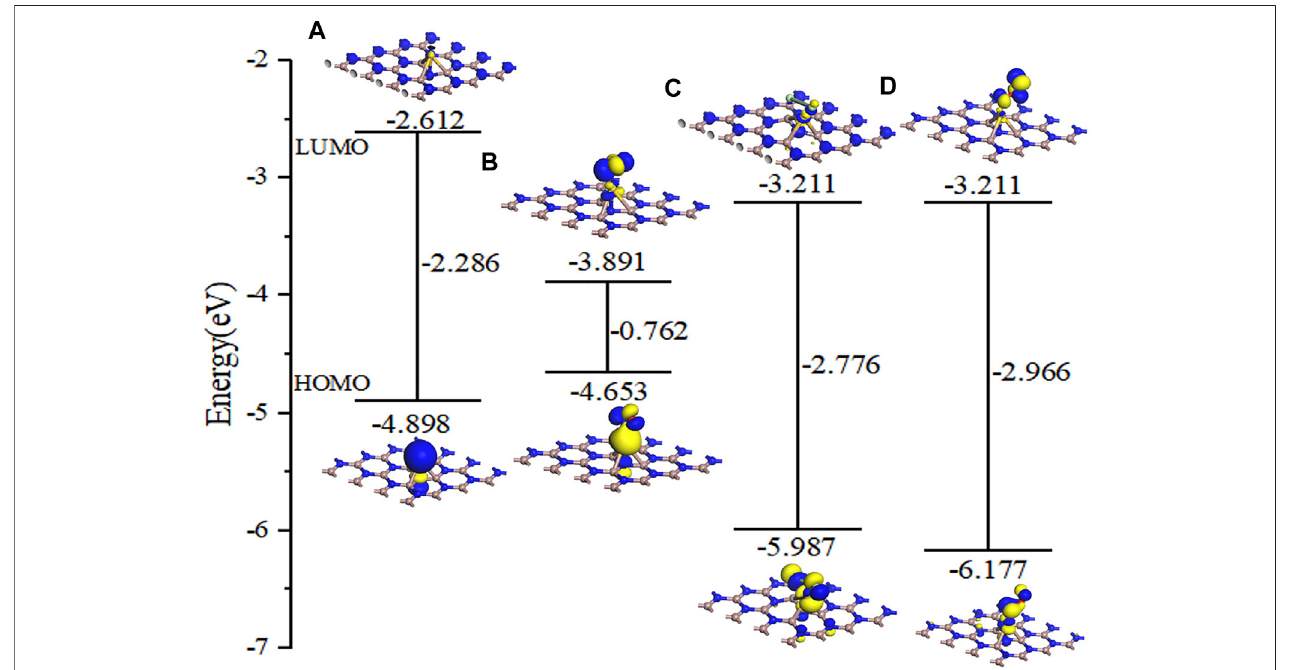
FIGURE 11 | Molecular orbital for (A) Au – GaN monolayer, (B) NO, (C) Cl 2 , and (D) O 3 on the Au – GaN